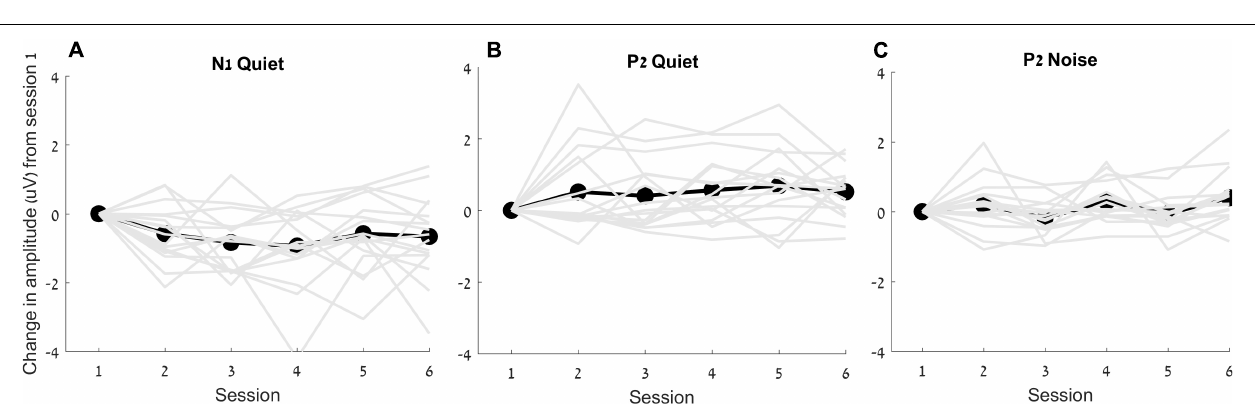
FIGURE 5 | Change in amplitudes (in µ V) from the first session for N1 in quiet (A) , P2 in quiet (B) and P2 in noise (C) are plotted for each individual (gray lines) as well as for the average (black